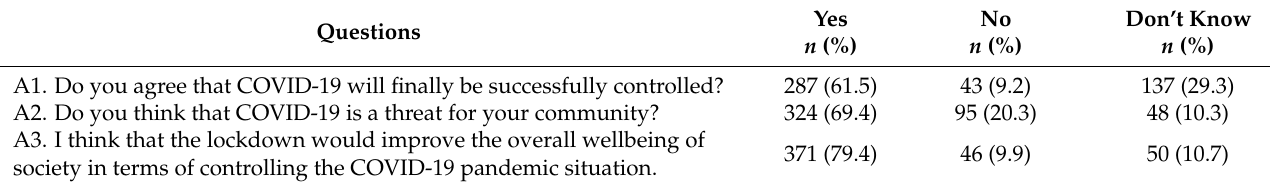
Table 4. Attitudes toward COVID-19 among participants.